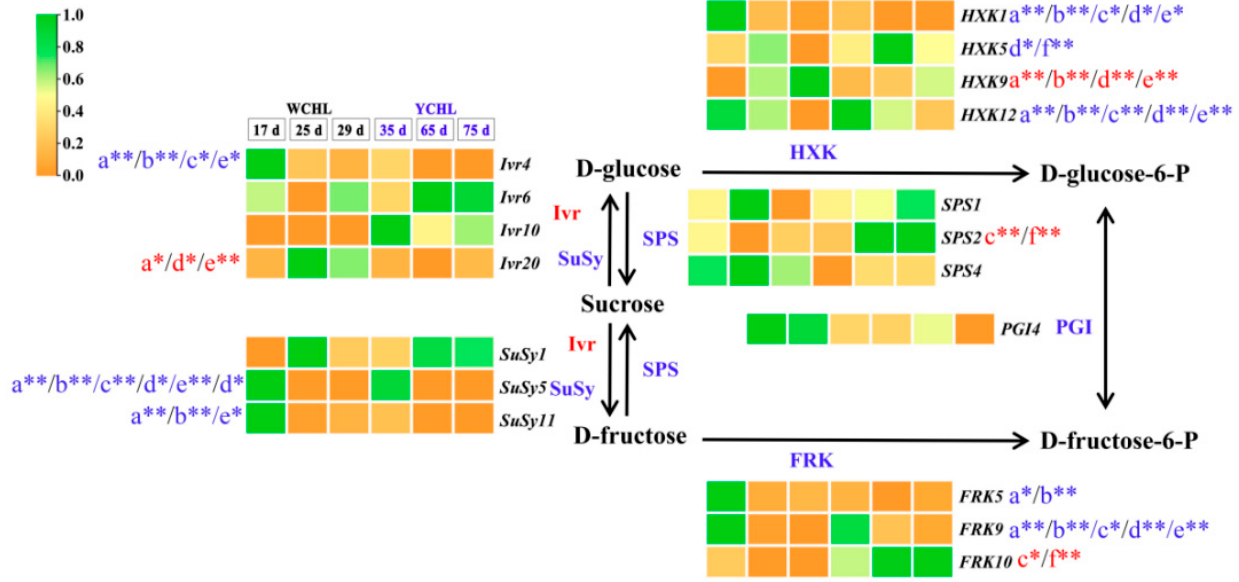
Figure 8. The proposed major sugar synthesis pathways and transcript abundance of their genes in ‘WCHL’ and ‘YCHL’ pitayas. Gene abbreviations are shown in Table S7. Letters a–f represent glucose, fructose, sucrose, sorbitol, galactose and inositol, respectively. The correlation analyses of main sugar contents and gene expressions are labeled as * ( p < 0.05, two-tailed) or ** ( p < 0.01, two-tailed), red indicates positive relationship while blue is negative.